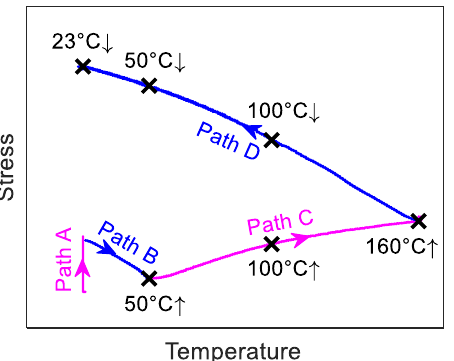
Figure 5. Stress versus temperature curve during the activation process. The FeMnSi-SMA is heated up from 23 °C to 160 °C and then cooled down to 23 °C. The black cross-marks show the target temperatures of the interrupted thermal-mechanical experiments.